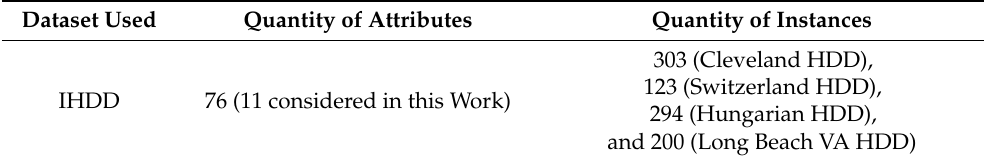
Table 2. A brief summary of the IHDD Dataset.